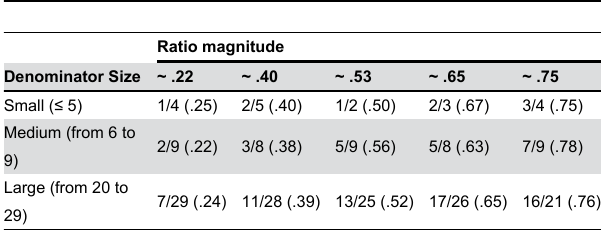
Table 1. Overview of the ratios to be estimated.